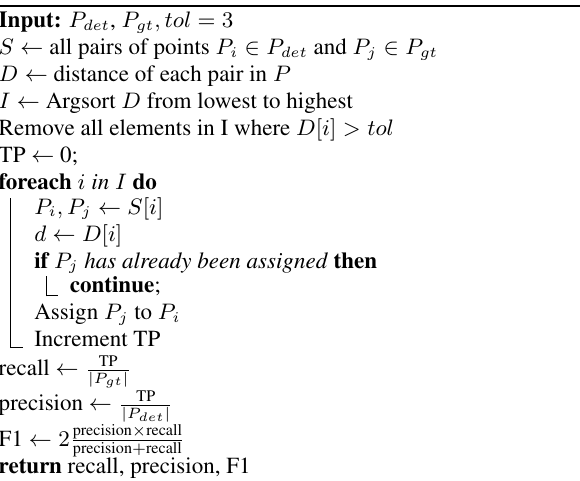
Algorithm 1: Recall, precision and F1 measurements